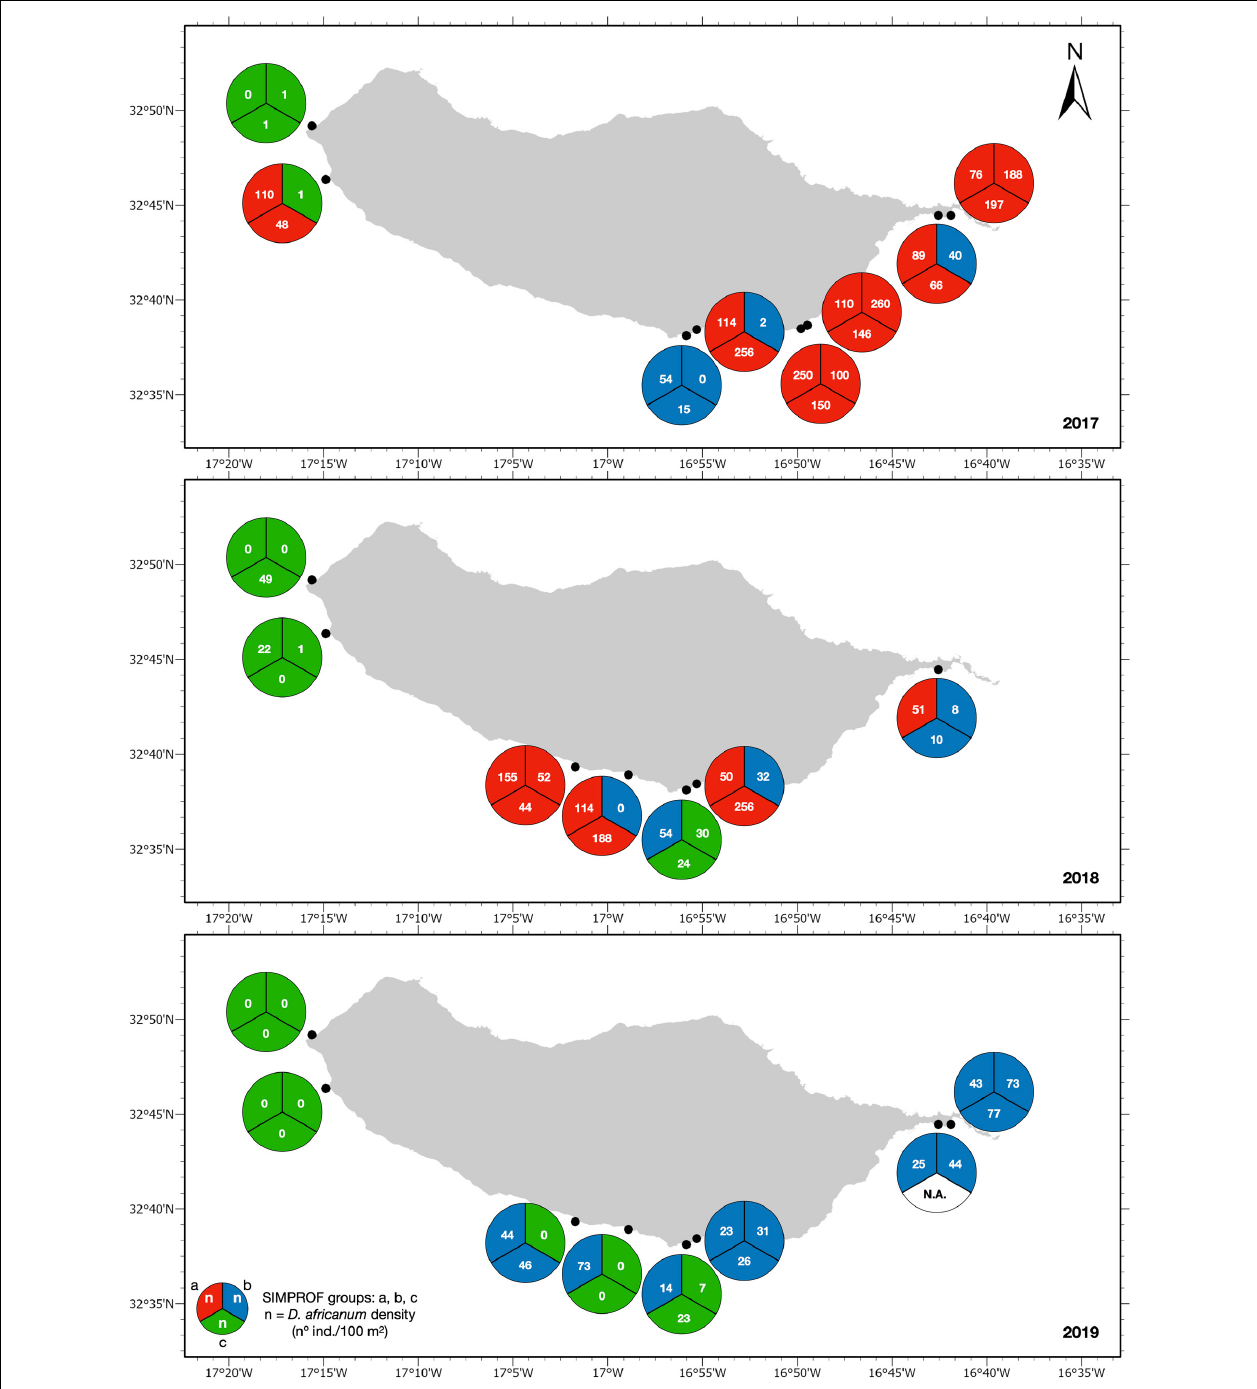
FIGURE 6 | Identified assemblages (SFG = a, b, c; colors) and D. africanum density (individuals/100 m 2 ) in each transect (pie chart slices) for sites surveyed in 2017 (top), 2018 (middle), and 2019